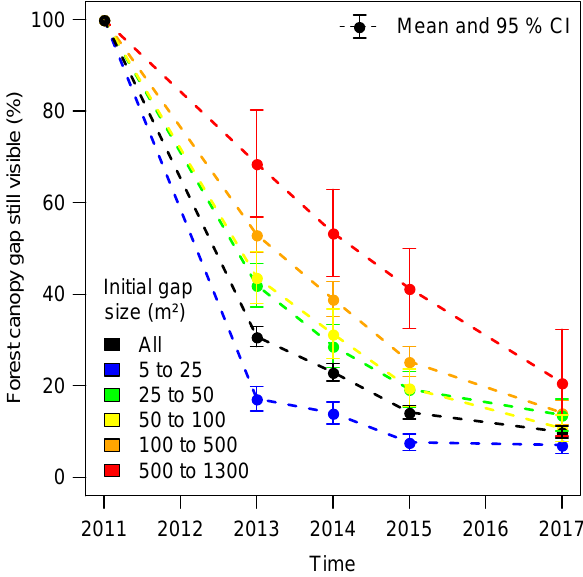
Figure 7. Filing of forest canopy gaps over time (2011 to 2017) in Jamari National Forest (UPA-01), as a function of the initial gap size class (m 2